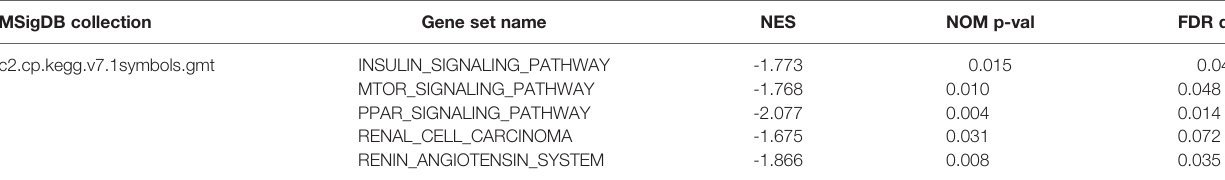
TABLE 3 | Results of gene set enrichment